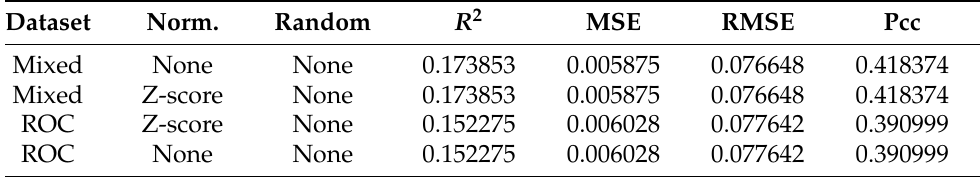
Table 2. Top 2 best metric performers in Linear regressor.